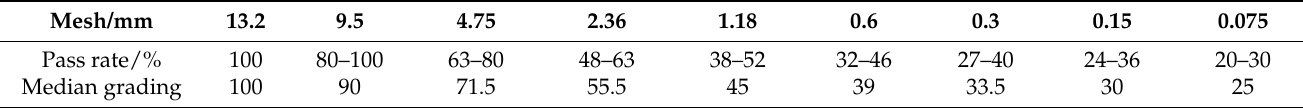
Table 8. CGA-10 matching requirements